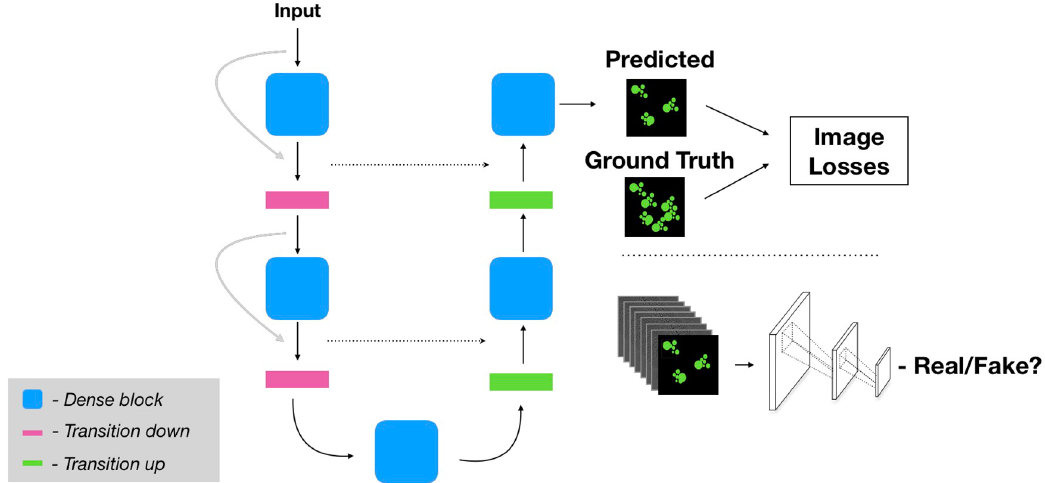
Fig 5. Proposed model for virtual staining of the lipid droplets. The base model is extended with a patch-level discriminator, used for adversarial training, in combination with intensity and gradient-based loss functions.